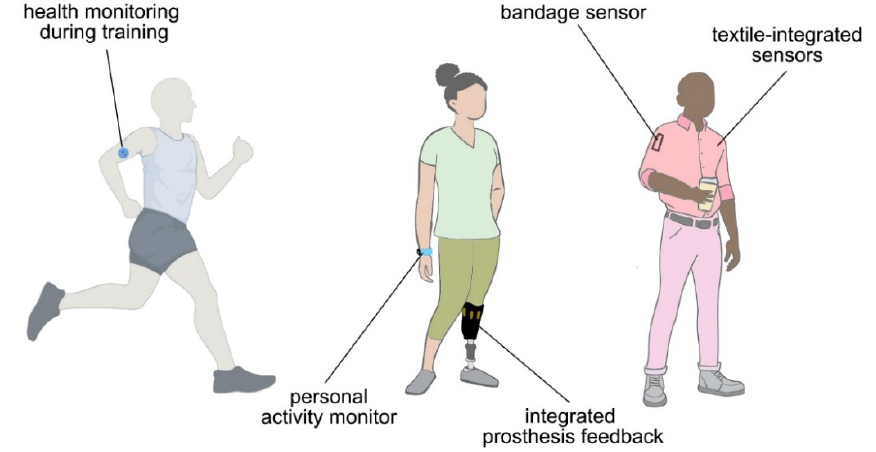
Figure 1. Wearable sensor past, current, and future. Early sensors focused on monitoring training of military personnel and athletes. Current personal electronics boom integrates activity and health monitoring into existing electronics (smart phones, watches, prosthetics). Future wearable devices aim to seamlessly integrate into our daily life for continuous feedback on our health. (This image was created using BioRender, Office, and Adobe products.).